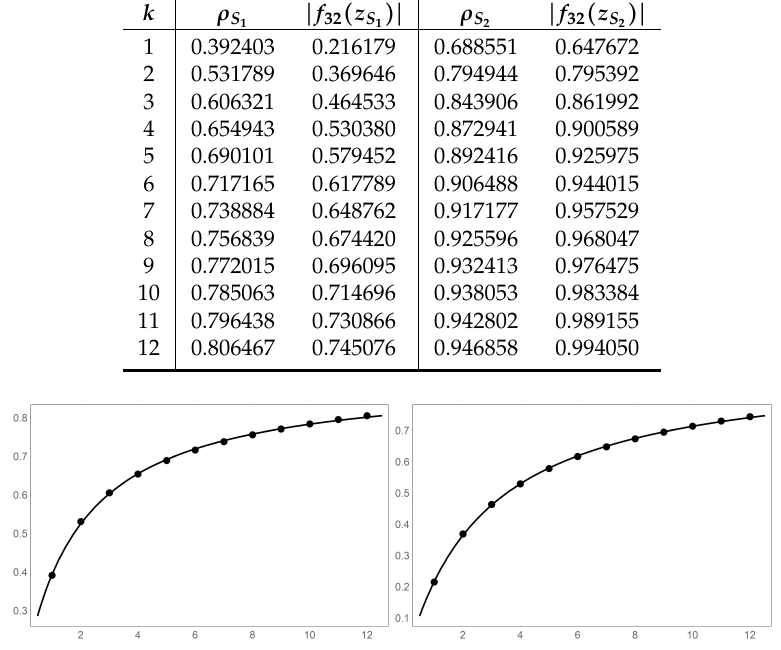
Figure 21. Plots of data for ρ S ( left ) and | f 32 ( z S ) | ( right ) versus k from Table 1. Each data set is fit to (cid:16) (cid:17) + c A x a Langmuir isotherm . Fit values: ( ρ S ; A = 0.7831, b = 1.9360, c = 0.1282) and ( | f 32 ( z S ) | ; x + b A = 0.9588, b = 2.7512, c = −